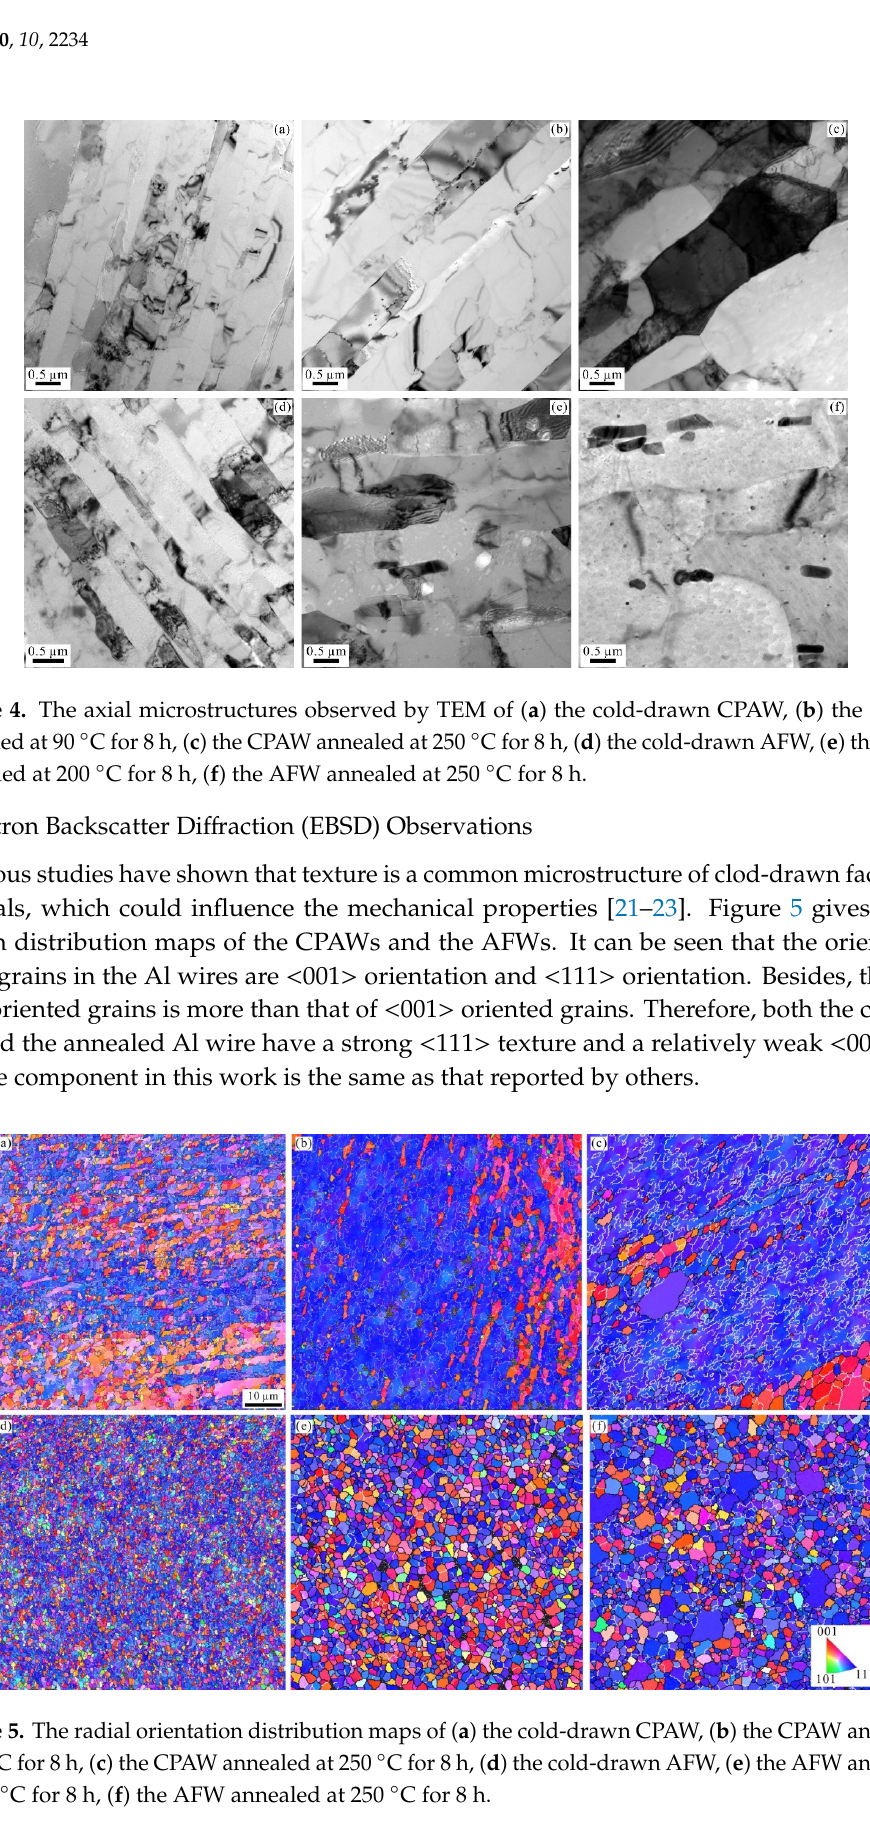
Figure 3. The radial microstructures observed by TEM of ( a ) the cold-drawn CPAW, ( b ) the CPAW annealed at 90 °C for 8 h, ( c ) the CPAW annealed at 250 °C for 8 h, ( d , g ) the cold-drawn AFW, ( e , h ) the AFW annealed at 200 °C for 8 h, ( f , i ) the AFW annealed at 250 °C for 8 h.